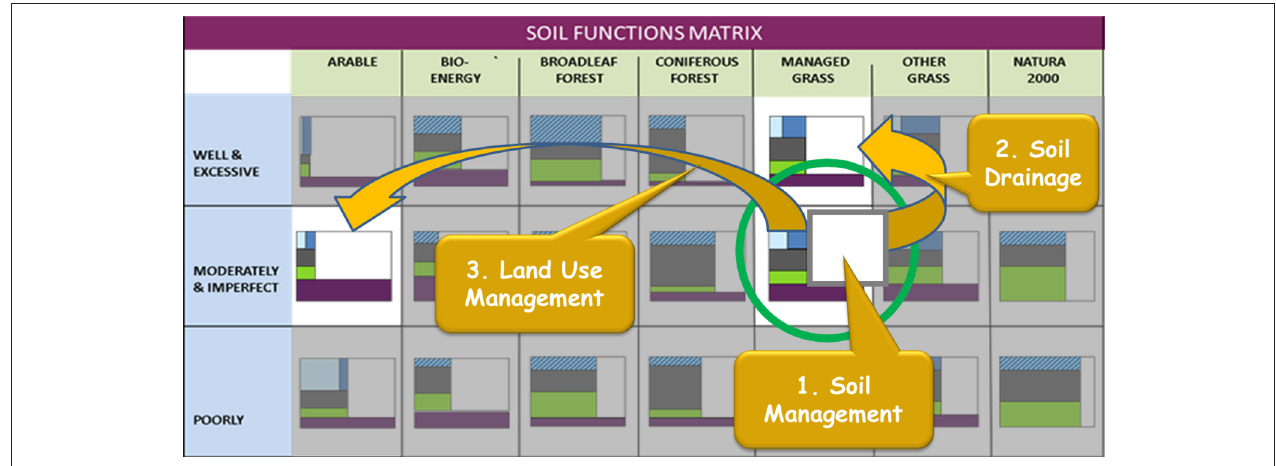
FIGURE 6 | Illustration of pathways for managing soil functions in Atlantic climates: (1) soil management, (2) soil drainage, and (3) land use management. The white boxes indicate primary production; blue, water purification and regulation; black, carbon storage and regulation; green, provision of a habitat for biodiversity; purple, cycling of